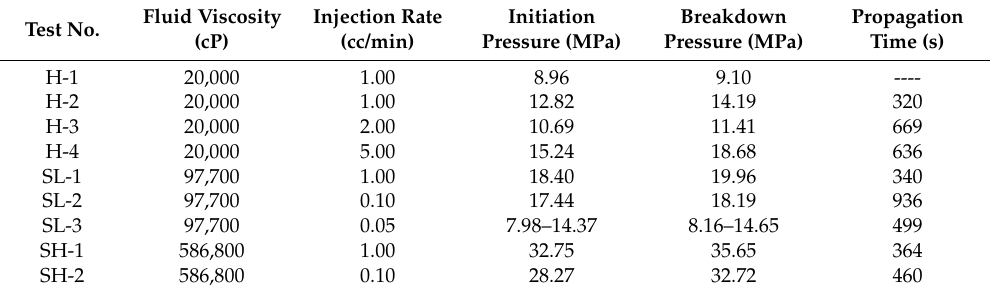
Table 4. Fracturing tests’ parameters and main results.